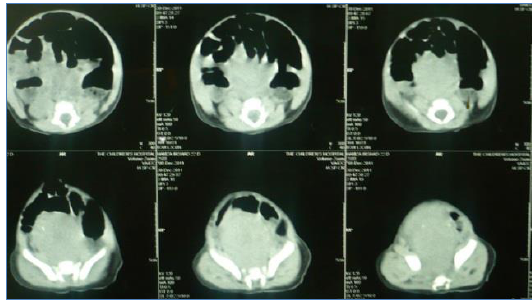
Figure 2: A presacral mass with calcifications.